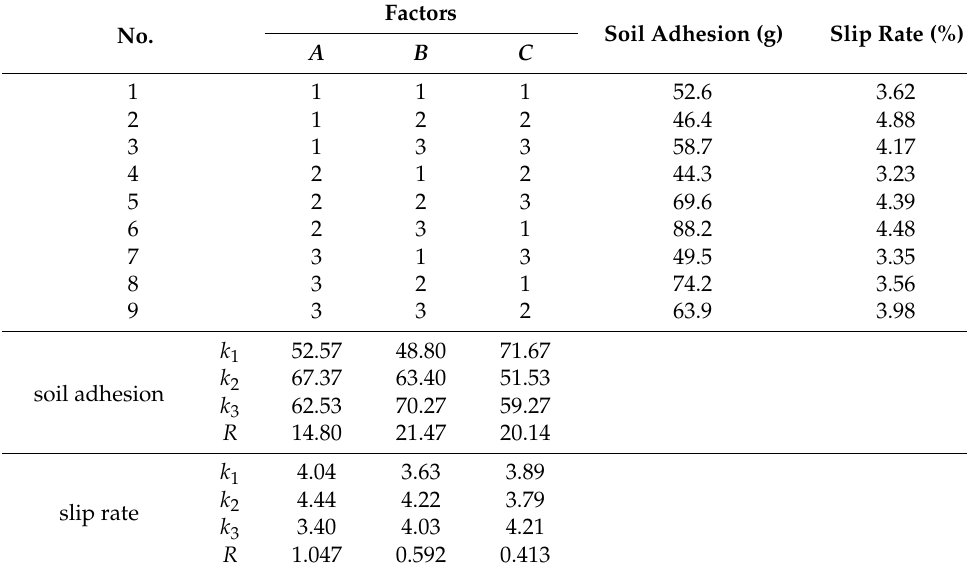
Table 2. Results of orthography experiment and range analysis.